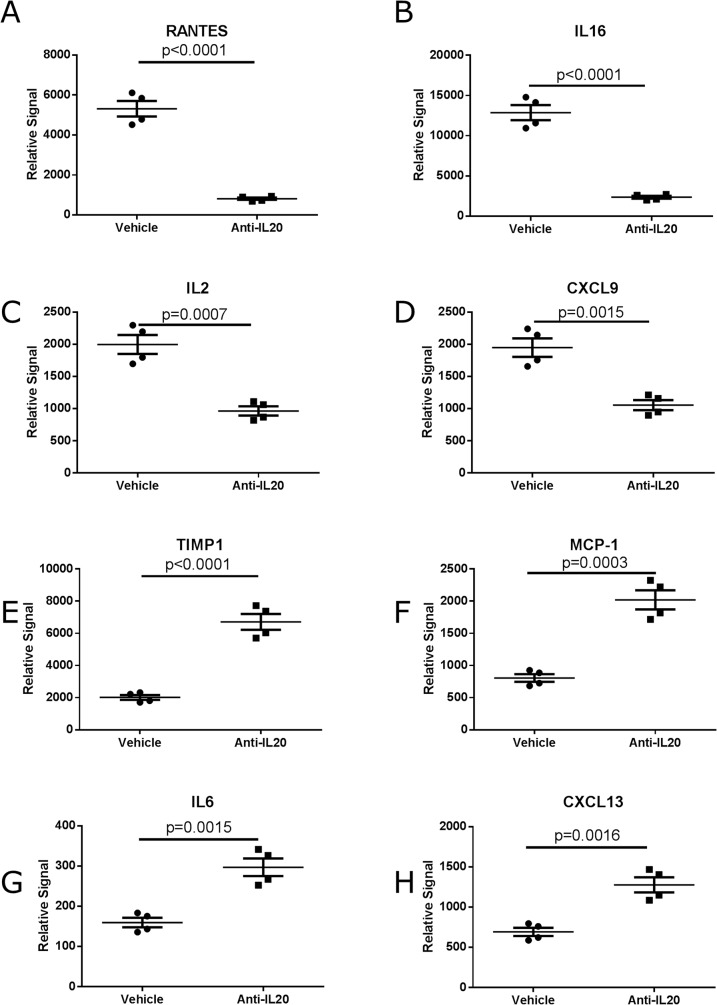
Proteins regulated in the diabetic pancreatic tissue after anti-IL20 antibody treatment compared to vehicle treatment.The proteins demonstrating most pronounced inhibition by anti-IL20 antibody treatment RANTES (A), IL-16 (B), IL-2 (C), CXCL9 (D). The proteins demonstrating most pronounced induction by anti-IL20 antibody treatment TIMP-1 (E), MCP-1 (F), IL-6 (G) and CXCL13 (H). Four pancreatic tissues were evaluated in each group. Statistical evaluation is performed with 1-way ANOVA.